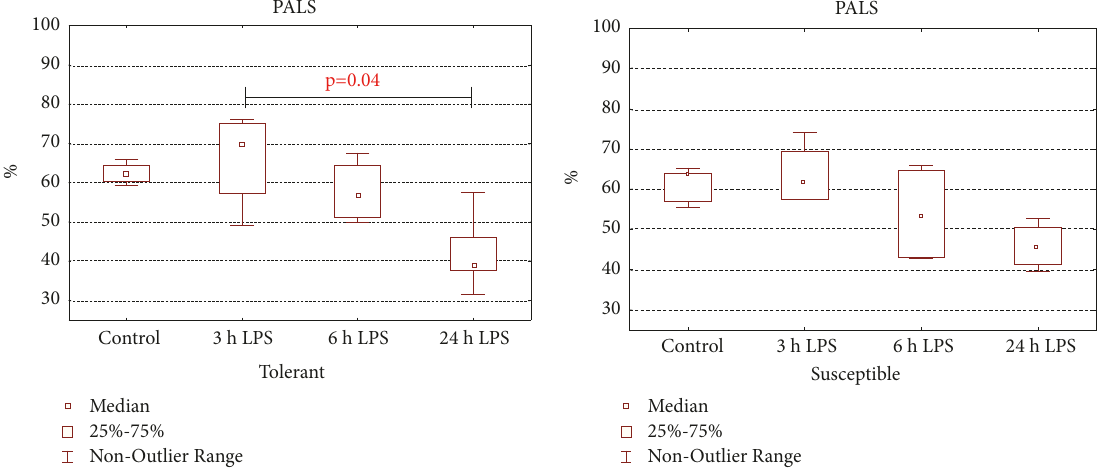
Figure 5: The volume fraction of the spleen PALS in tolerant- and susceptible-to-hypoxia rats after 3, 6, and 24 hours of LPS administration. Data are presented as median (25%, 75%); the statistical significance of differences ( p ) is determined by the Kruskal-Wallis method ( 𝑛 = 5 in each